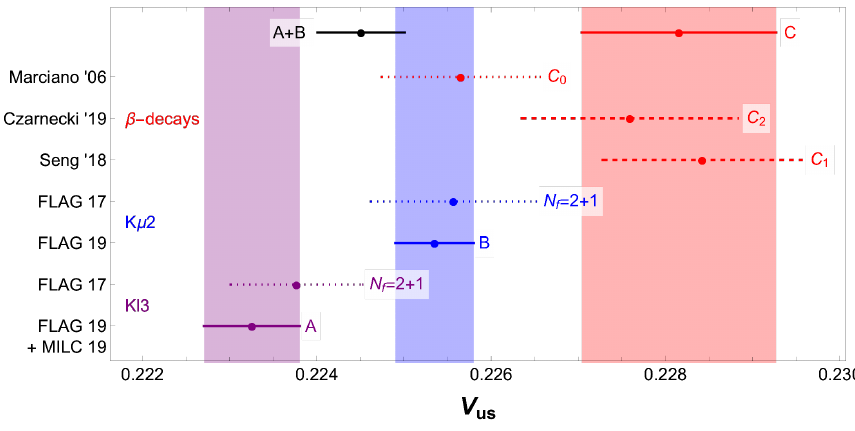
Figure 2 . Shaded areas show the values of | V us | obtained from determinations A (2.3), B (2.5) and C (2.10) by assuming CKM unitarity (1.3), while the black line corresponds to the democratic average of A and B (2.15) (see text). C 1 , C 2 are the values of | V us | obtained from the values of ∆ R reported by original references, as listed in table 1. For comparison we also show the values of | V us | obtained using 3 flavours lattice QCD simulations as reported in FLAG 17 [37] and adopted in Particle Data Group 2018. These determinations have practically no tension with the old determination C 0 [25]. Hence, this picture demonstrate that the CKM tensions in fact emerged due to improved precision of 4 -flavours computations [18, 19] on one side, and due to the changes in inner radiative correction ∆ R [26, 27] on the other